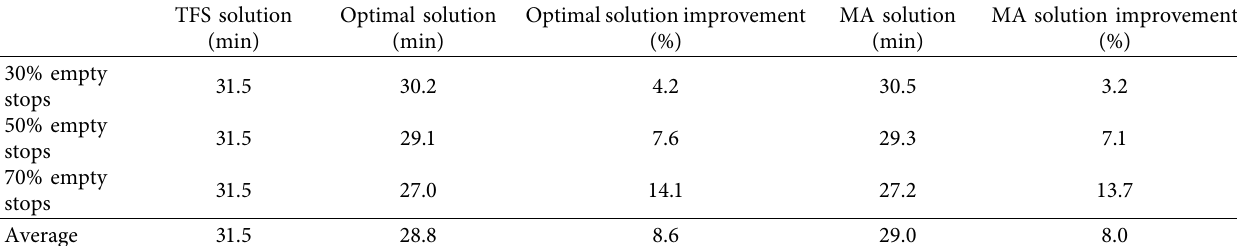
Table 6: Average passenger travel time in the TFS, with optimal routes and the MA. Improvement of optimal and MA solution compared to TFS, classifed according to the percentage of empty bus stops in the instance.